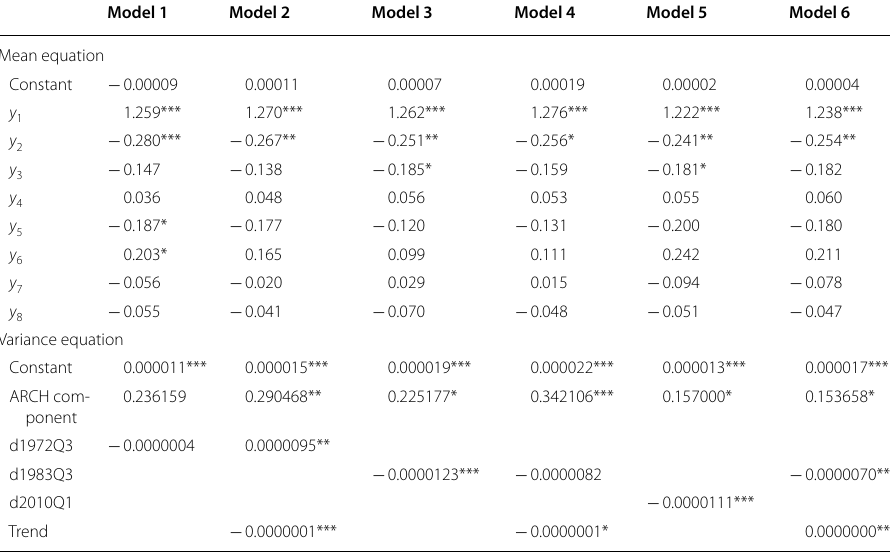
*indicates statistical significance at 10 %, **at 5 %, ***at 1